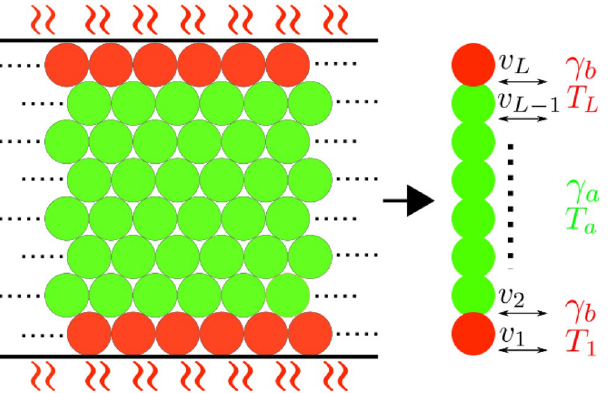
Figure 2. Sketch of the model and relation with higher dimensional systems. On the left we suggest a hypothetical 2D dense granular system where particles are roughly located on the vertices of a regular lattice. A possible mapping from the 2D to the 1D system involves replacing the mean horizontal velocity on the i th layer of the 2D system and replacing it with the v i of the 1D system. The dynamics in the vertical direction is neglected, an approximation which is justified by the presence of the vertical confinement, while the periodic boundary conditions (indicated by the dotted lines) are representative of a ‘free’ direction in which the grains can flow without obstacles. This can be realized experimentally, for instance, in a 3D cylindrical geometry, where the velocity of grains in the tangential direction (with respect to the central axis of the cylinder) constitute the horizontal velocities in the putative 2D system sketched here, see for instance 8,9 . Red grains are in direct